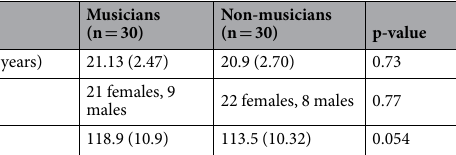
Table 1. Overview of demographic averages for 30 musicians and 30 non-musicians. Standard deviations are in parentheses. Table also show p-values for comparison of the two groups. Independent-samples t-tests were used to compare age and IQ, and a χ 2 test was used to compare distribution of gender distribution in the two